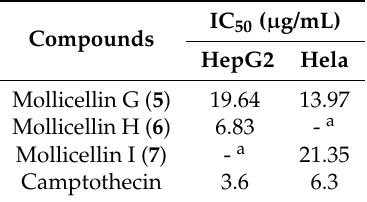
Table 4. Cytotoxic activities.